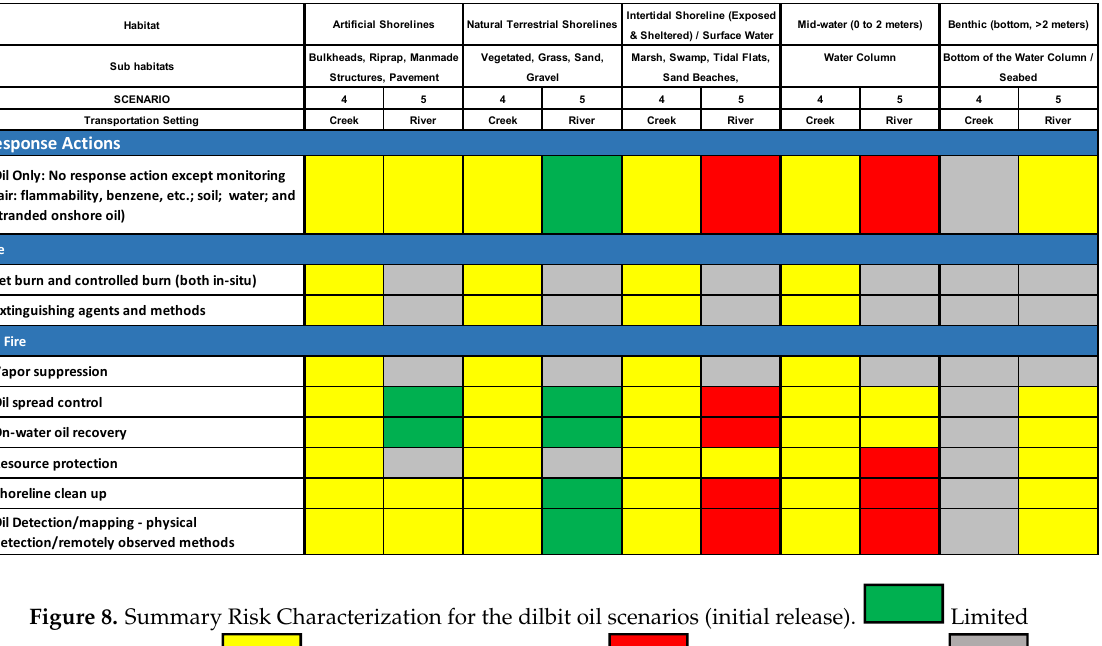
Figure 9. Summary Risk Characterization for the dilbit oil scenarios (initial release). Limited Figure 8. Summary Risk Characterization for the dilbit oil scenarios (initial release). Figure 7. Summary Risk Characterization for the Bakken oil scenarios (initial release). Figure 7. Summary Risk Characterization for the Bakken oil scenarios (initial release). Figure 7. Summary Risk Characterization for the Bakken oil scenarios (initial release). Level of Concern; Moderate Level of Concern; High Level of Concern; Limited Level of Concern; Moderate Level of Concern; High Level of Concern; Limited Level of Concern; Moderate Level of Concern; High Level of Concern; Limited Level of Concern; Moderate Level of Concern; High Level of Concern; Not Applicable. Not Not Applicable. Not Applicable. Not Applicable.